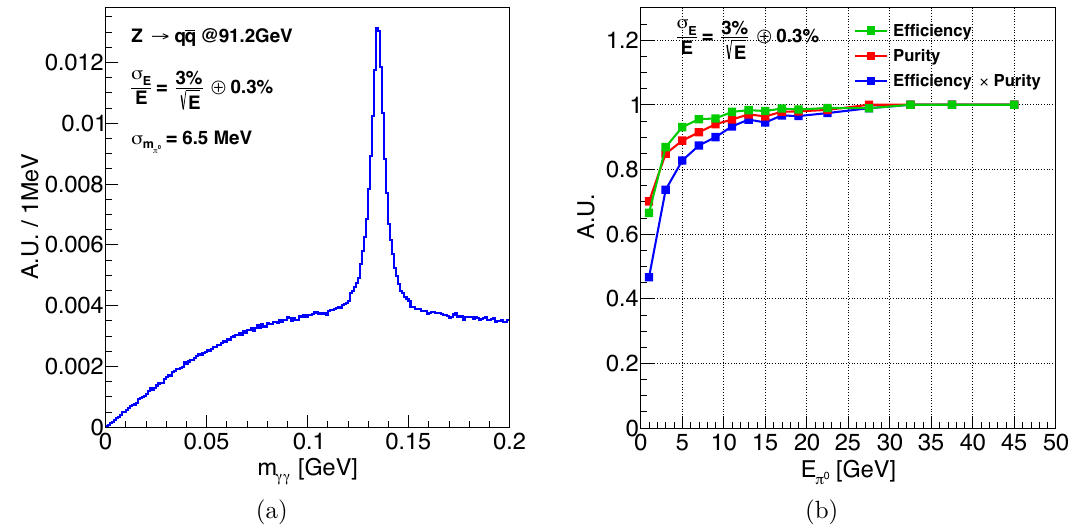
√ Figure 3 . π 0 reconstruction performance of the inclusive Z → q ¯ q ( s = 91.2 GeV) sample when the ECAL energy resolution is 3% √ ⊕ 0 . 3% . (a) Invariant mass spectrum of photon pairs with π 0 E mass peak around 135 MeV and the combinatorial background underneath. (b) Energy differential π 0 reconstruction efficiency and